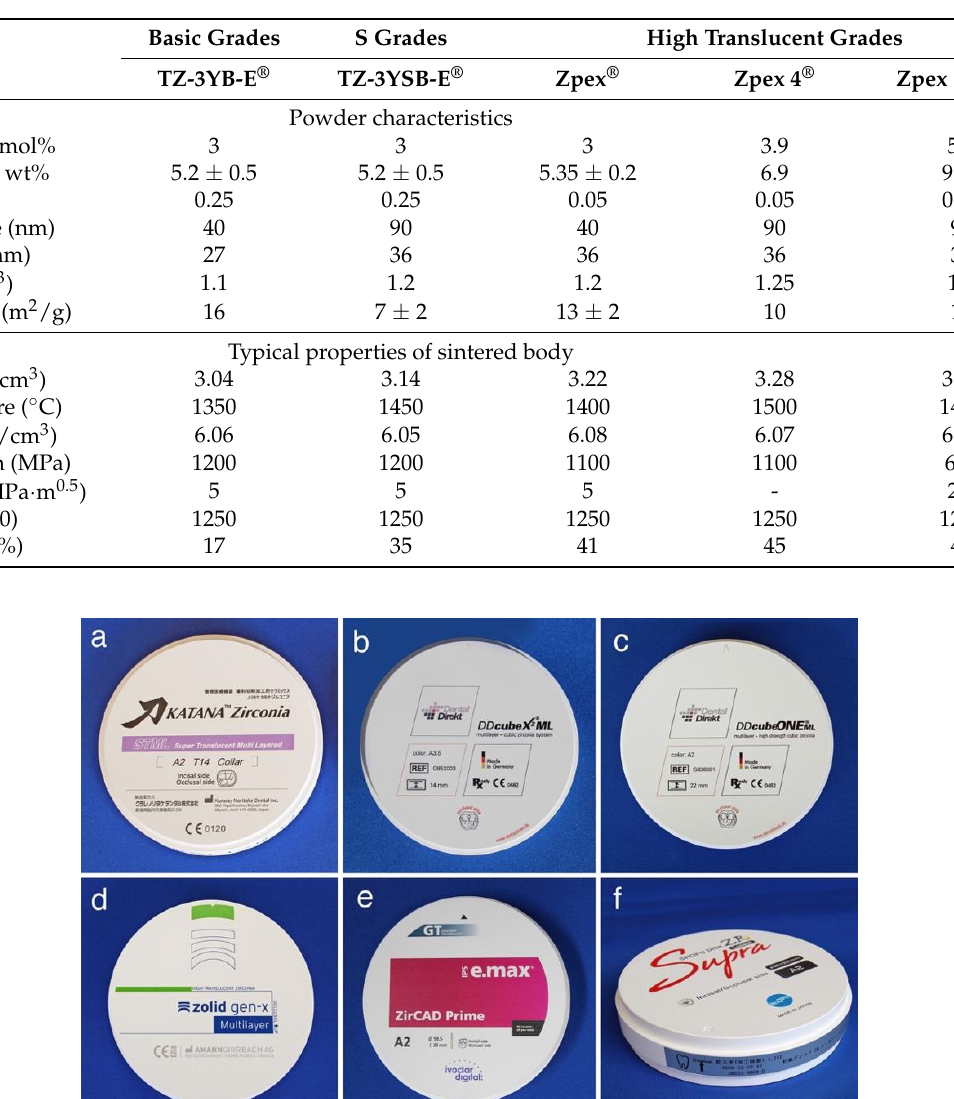
Table 1. Powder characteristics and typical properties of sintered body of zirconia (provided by Tosoh ® Corp. [28,29,31]).